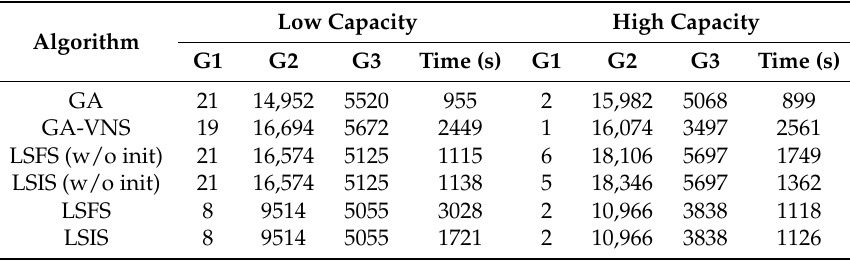
Table 2. Result of Case 2 (low capacity: 2000; high capacity: 4500).